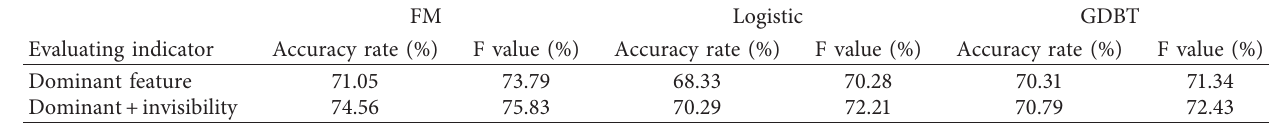
Table 2: Comparison of recommended performance of different classifier.